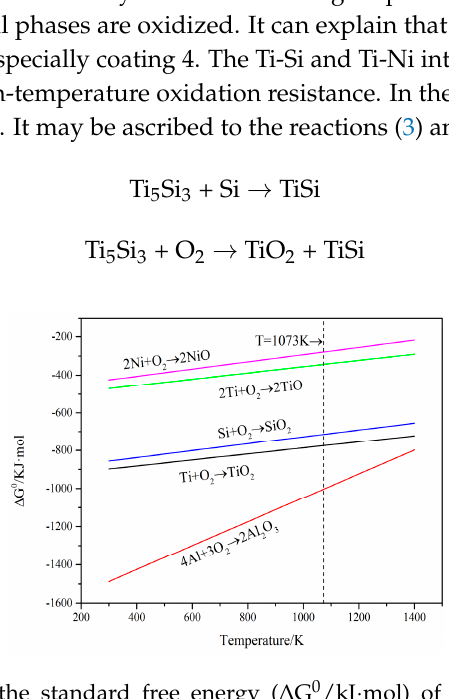
Figure 16. Variations of the standard free energy ( ∆ G 0 /kJ · mol) of formation of some oxides with temperature.